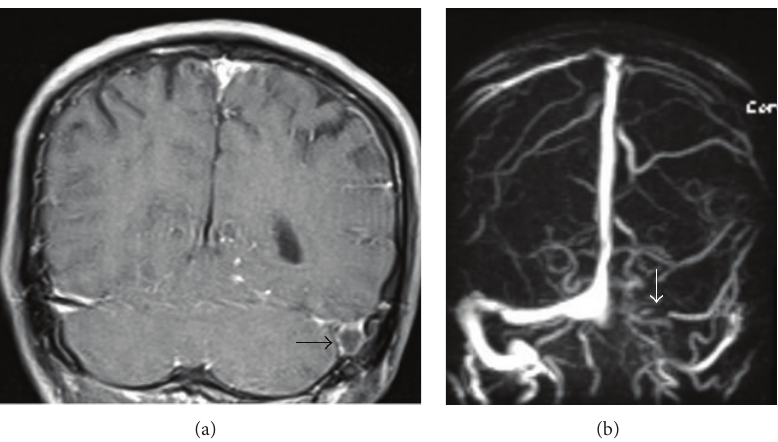
Figure 2: Dural venous sinus thrombosis as an only imaging evidence of tuberculous meningitis in a 45-year-old male who presented with headache and cerebrospinal fluid PCR positive for Mycobacterium tuberculosis . (a) Coronal postcontrast T1-weighted MR image demonstrates a filing defect within dilated left sigmoid sinus ( black arrow ). (b) MR angiogram reveals nonvisualization of transverse and sigmoid sinuses in left side ( white arrow